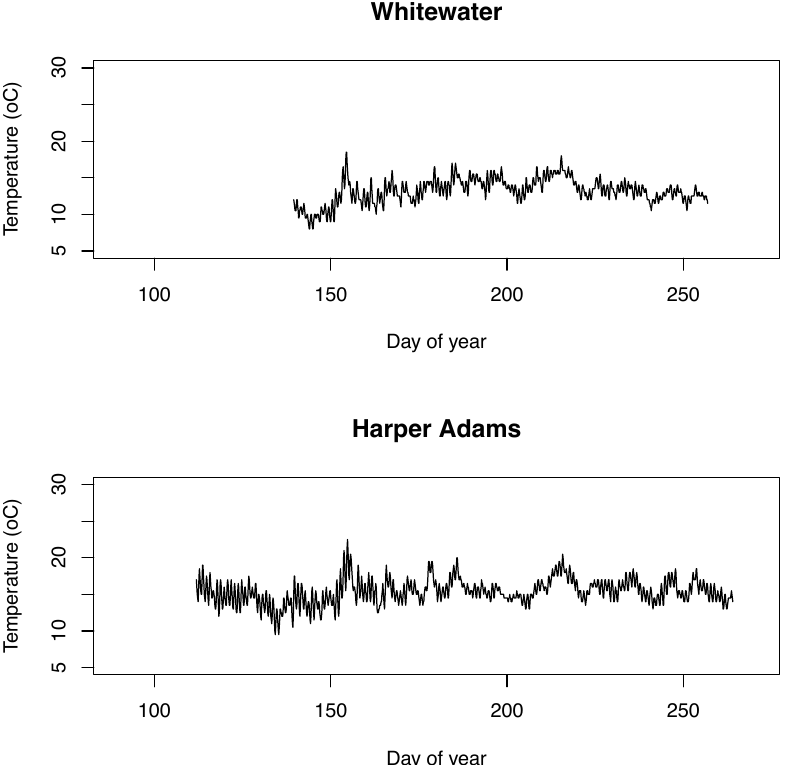
Figure 5. Soil temperatures in potato potato fields at 20 cm depth between planting and harvesting, taken at 3 h intervals at Whitewater, Scotland and Harper Adams, England for 2011.